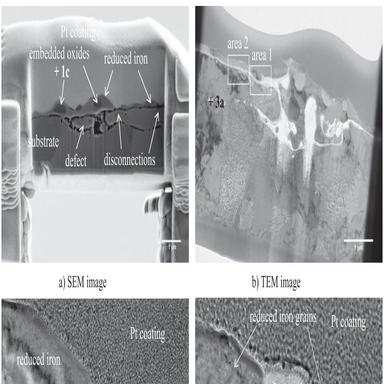
Cross-sectional SEM and TEM micrographs of the oixidized-reduced sample prepared by FIB. a) SEM image, b) TEM image, c) enlargement of area 1 in b), d) enlargement of area 2 in b).